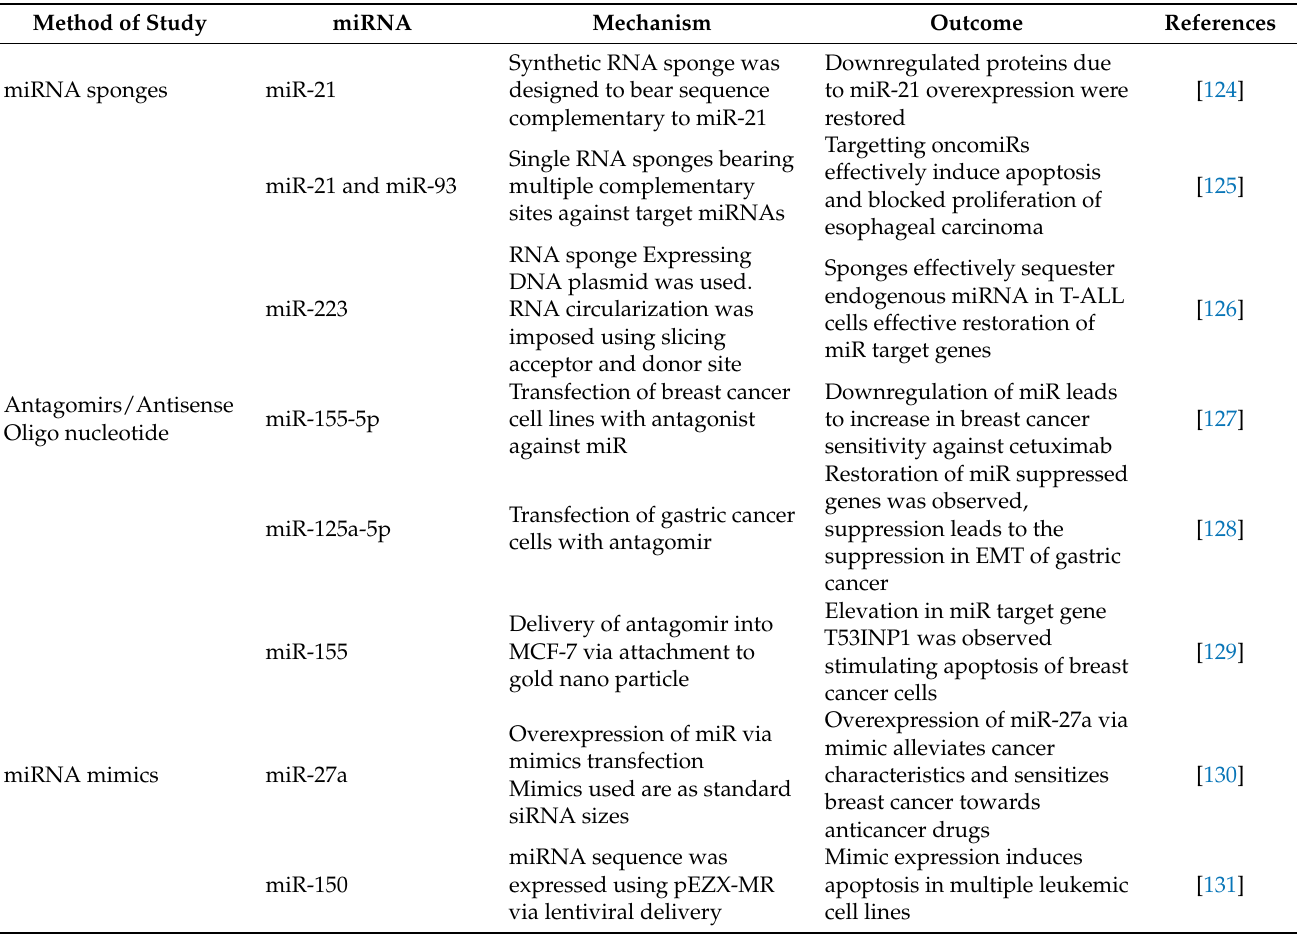
Table 2. Various conventional techniques to study miRNA